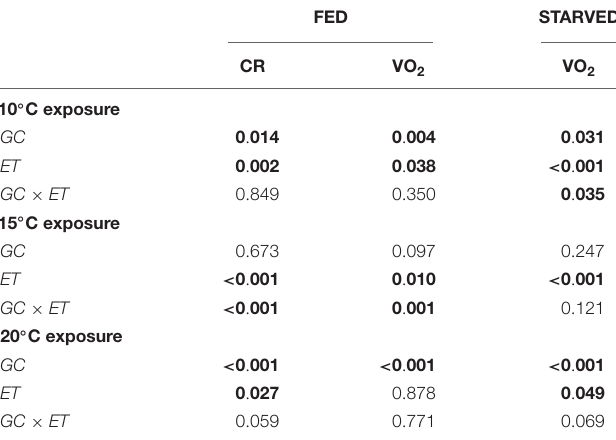
TABLE 3 | Two-way factor ANOVA (repeated measurements) showing the effects of growth condition (GC, F, or S) and exposure time (ET, day) on clearance rate (CR: L/h) and oxygen consumption (VO 2 : mLO 2 /h) in fed and starved mussels reared at 10 ◦